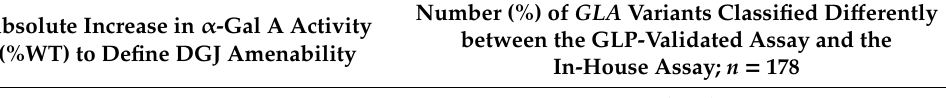
Table 3. E ff ects of di ff erent thresholds for absolute enzyme activity increase (%WT) as the only criterion for defining amenability of GLA variants when comparing data from the in-house assay and the GLP-validated